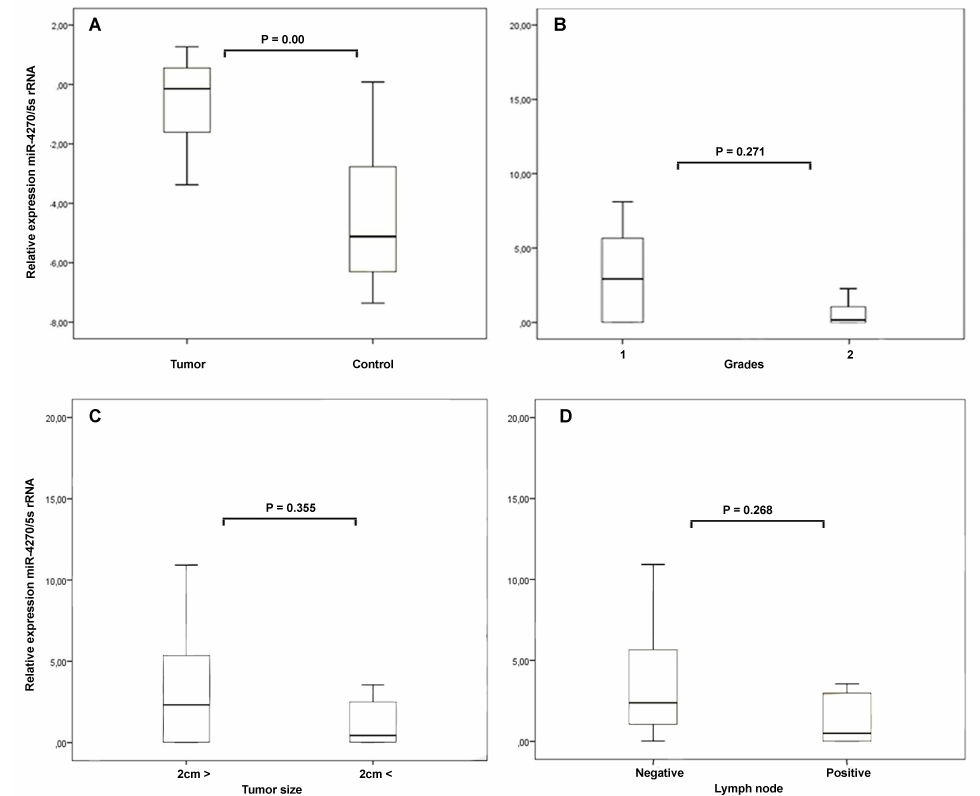
Fig. 1. Relative mean expression of miR-4270 in plasma A) tumor and control specimens; B) tumor grades 1 & 2; C) tumor size, and D) samples with low and high incidence of lymph node metastasis; P-value more than 0.05 is not